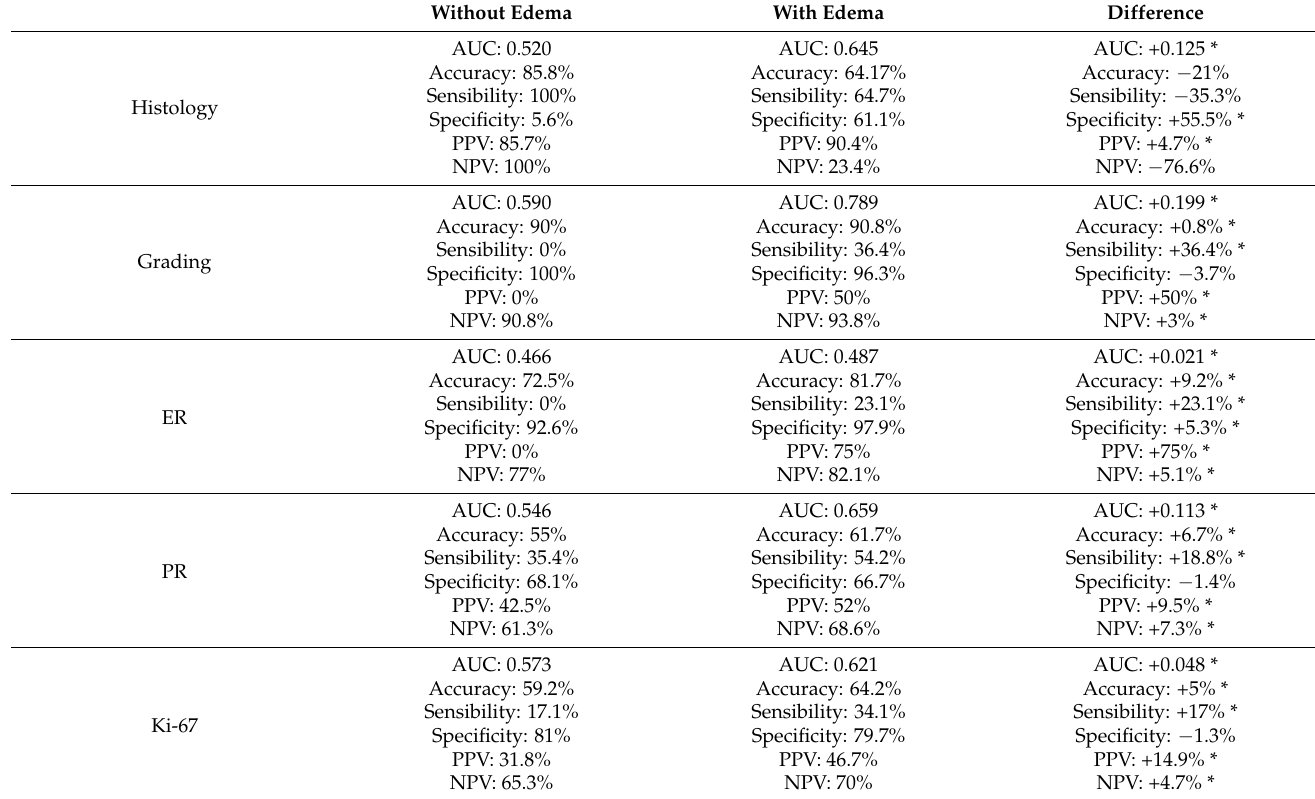
Table 3. The AUC and the accuracy for each histological label are obtained, at first, using only the semantic features (second column) and, then, adding the edema radiomics features (third column). In the last column is reported the difference between the two AUC/accuracies, indicating with * the cases in which edema radiomics features increased the result. Without Edema With Edema Difference AUC: 0.520 AUC: 0.645 Histology